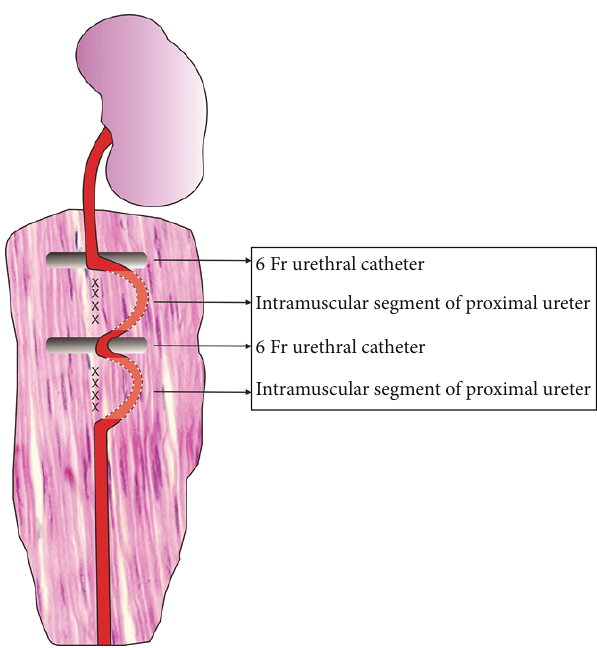
Figure 1: Surgical technique model, “W”